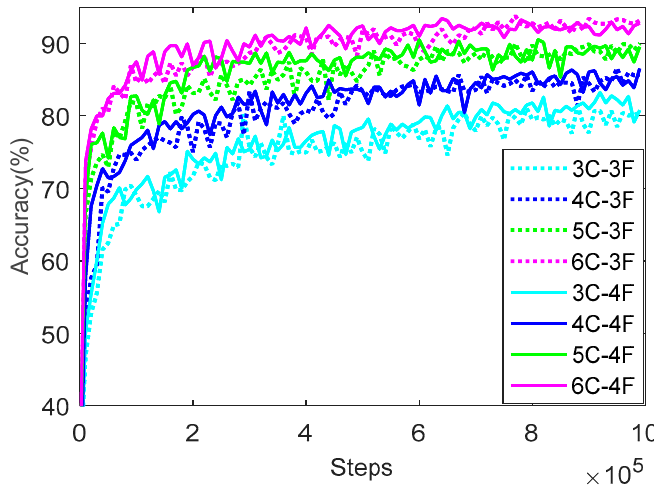
Figure 6. Prediction accuracy of CNN with different layers using the training set.